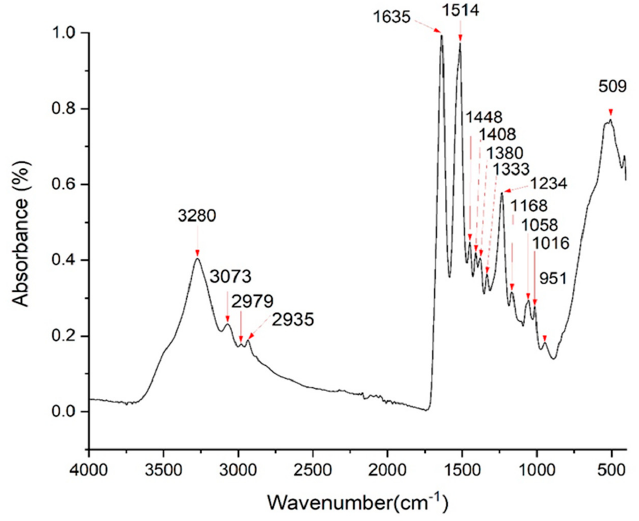
Figure 3. FTIR spectra of the silk fibroin (Luang Saraburi).